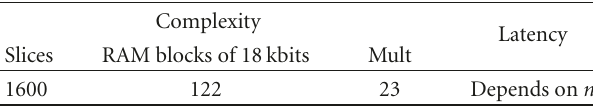
Table 2: Complexity evaluation of the DVB-T